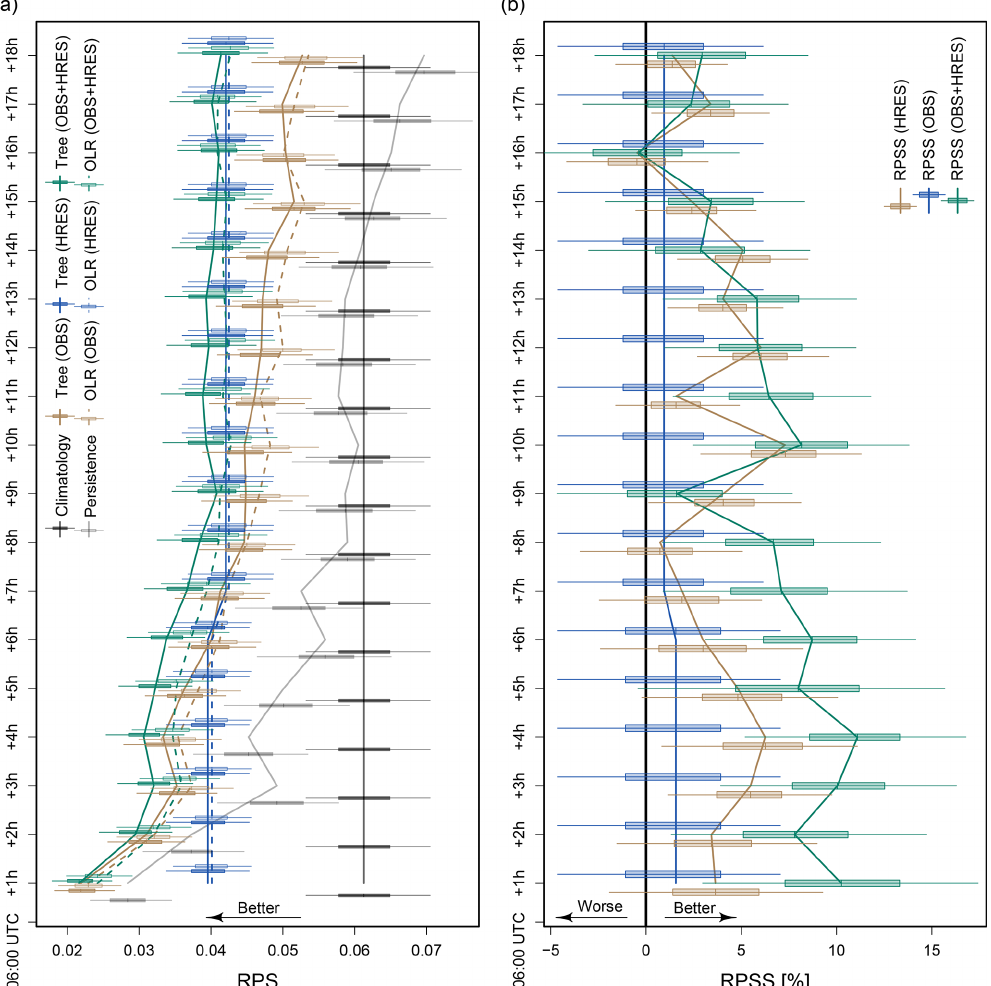
Figure 1. Forecast performance of boosting tree models and the references OLR, persistence, and climatology. The statistical models are based on observations (OBS), NWP model output of the deterministic HRES ECMWF model (HRES), and their combination (OBS+HRES). The forecast validation time is always 06:00UTC. Models with a lead time of + 1h ( + 2h, ...) are initialized at 05:00UTC (04:00UTC, ...). The lines show the median performances, and the related boxes show the 25th to 75th percentiles with the 5th to 95th percentiles as whiskers. (a) RPS of each individual model. (b) RPSS of the boosting trees with OLR as reference. Boosting trees based on observations have the OLR based on observations as reference (the same applies for the HRES model and the combined predictor setup). The RPSS numbers show the percentage of improvement in the boosting tree performance over